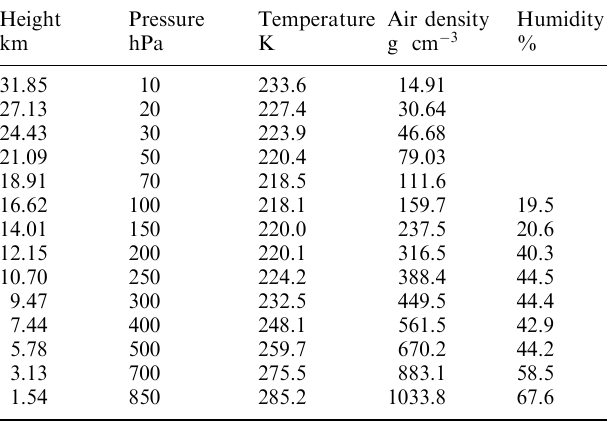
Table 9. Radiosonde values over southern Germany in the month of July, averages from 1981 to 1985